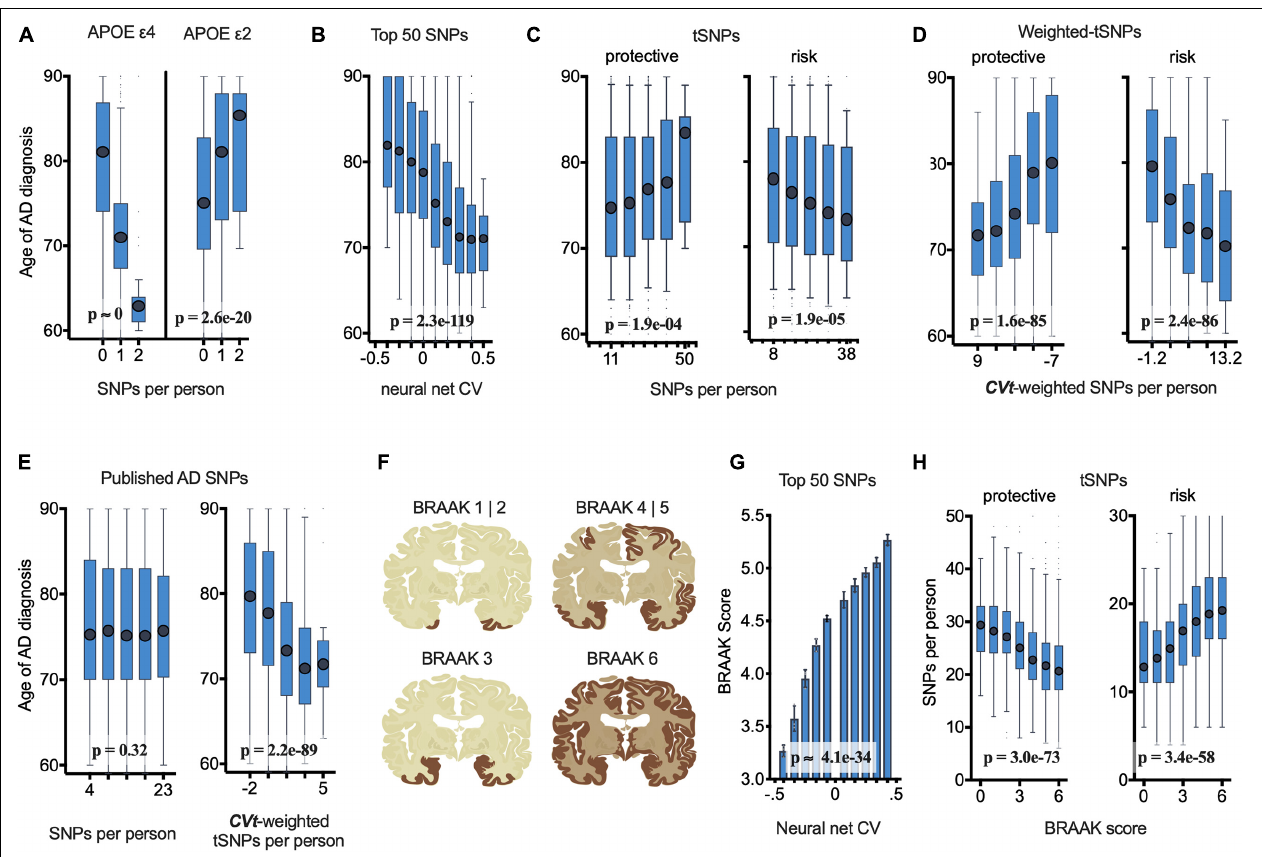
FIGURE 4 | netSNP validation: Number of netSNP-identified tSNPs and netSNP-CVt-weighted tSNPs correlate with age of AD diagnosis of all case individuals ( N = 4752) and AD pathology (case and control receiving autopsy, N = 2700). (See Supplementary Figure 8 for results excluding APOE and TOMM40 in netSNP training matrices; results are similar; conclusions are the same.) (A) Age of AD diagnosis plotted against the number of APOE e4 (or APOE e2) SNPs per person. Here and below: boxplot X -axis values indicate mean value of boxed group; p -values based on general linear model analysis of variance. (B) Age of AD diagnosis plotted versus 50 SNP neural net CV. (C) Age of AD diagnosis plotted versus number of netSNP-identified AD-protective, left, or AD-risk tSNPs. (D) Age of AD diagnosis plotted versus netSNP-CVt-weighted number of AD-protective (left) and AD-risk (right) tSNPs. (E) Age of AD diagnosis plotted versus number (left) or netSNP-CVt-weighted number (right) of previously published AD-linked SNPs, excluding those in APOE/TOMM40. n.s., not significant. (F) Diagram of human brain with affected regions for indicated Braak scores. (G) Neural net CV plotted versus Braak score. (H) netSNP-identified AD-protective (left) and AD-risk (right) tSNPs per person plotted versus Braak